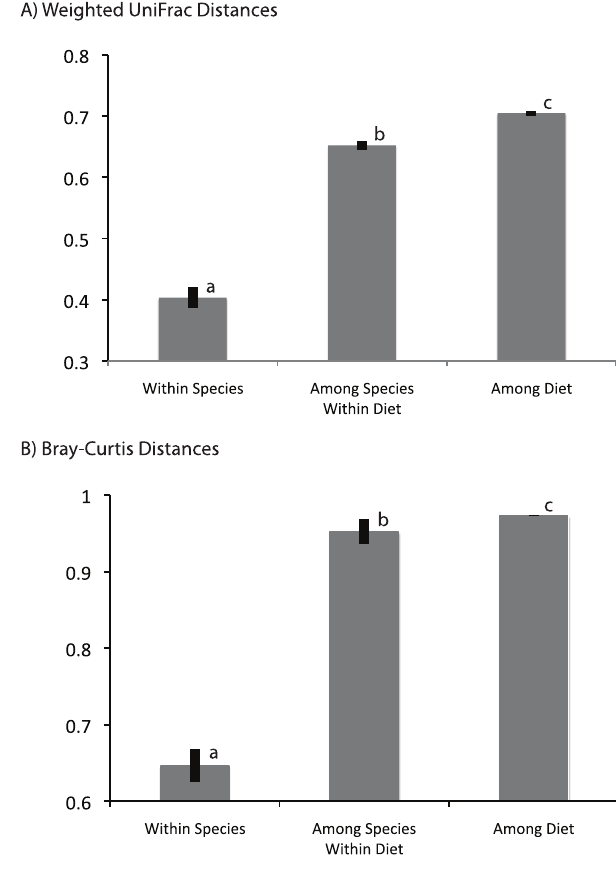
Figure 5. Effect of diet on bacterial community dissimilarity. Average weighted UniFrac (A) and Bray-Curtis (B) dissimilarity values of bacterial communities from specimens within species, among species/ within diet classification, and among diet classifications. Error bars represent standard error.